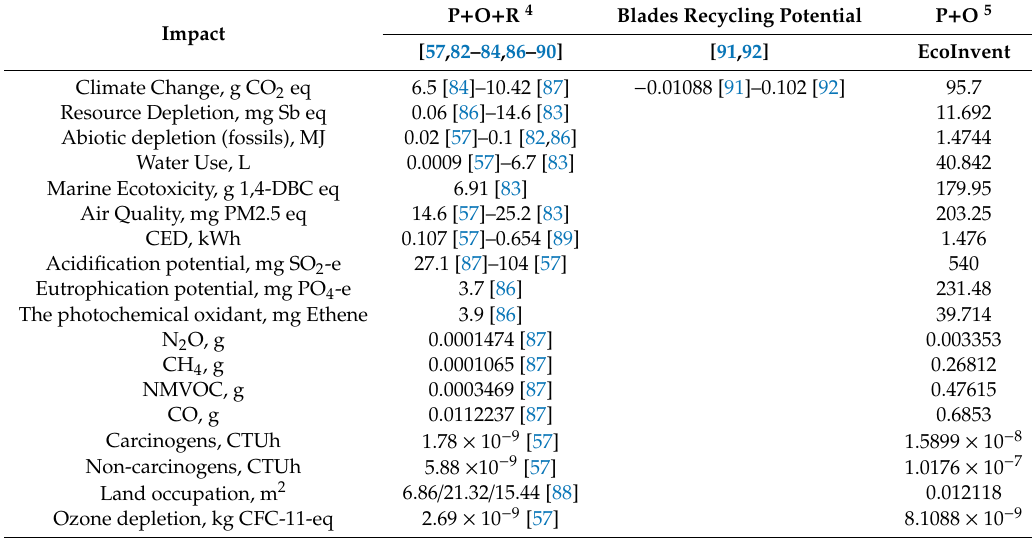
Table 6. Environmental impacts of di ff erent life cycle stages of wind plants (for 1